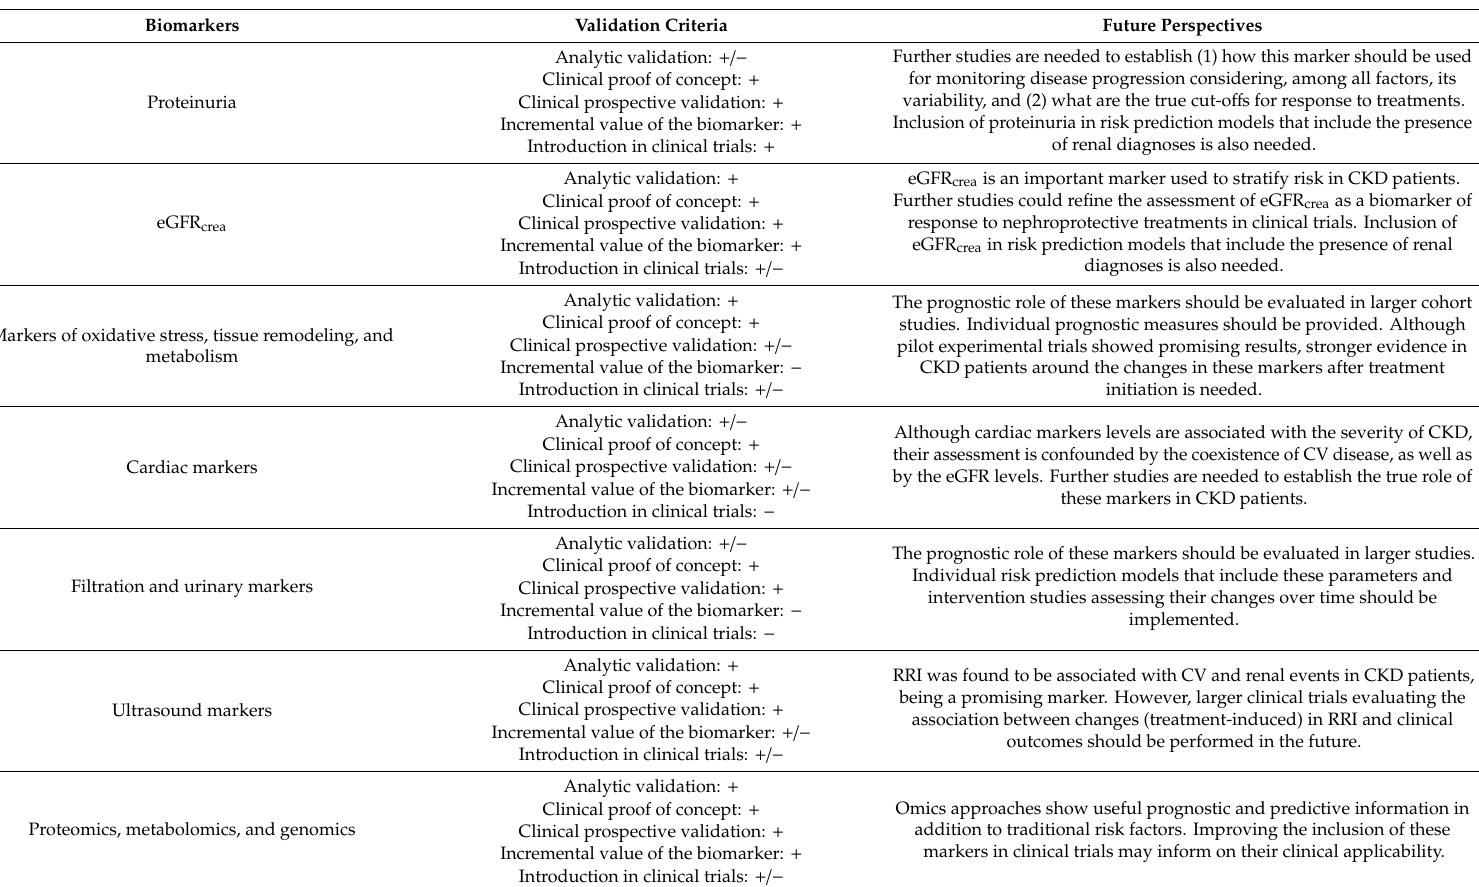
Table 3. Validation score and future perspectives in the development of biomarkers in CKD